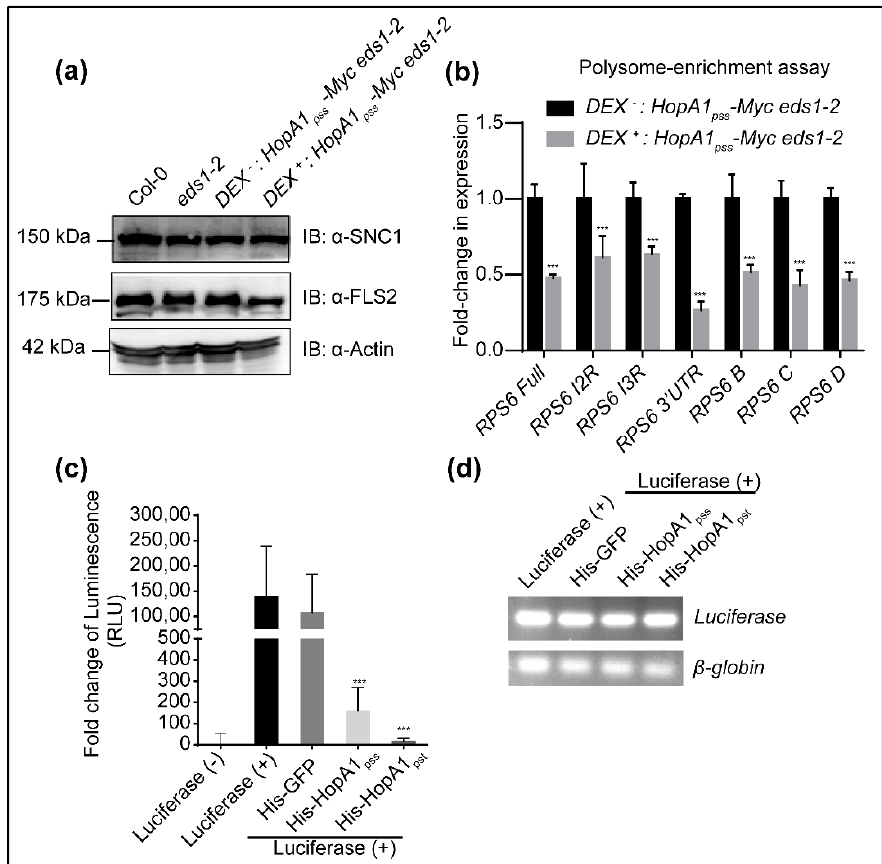
Figure 6. HopA1s display translational suppression activity. ( a ) Expression levels of SNC1 and FLS2 proteins in Col-0, eds1-2 , Dex − and Dex + HopA1 pss -expressing transgenic plants at 12 hpin. Immunoblots were performed with anti-SNC1, anti-FLS2 or with anti-actin as representative of loading control. ( b ) Transcript levels of RPS6 AS variants enriched on polysomes during ETI HopA1pss -like response. Values are mean ± SD of three replicates and shown as relative to Dex − levels. Statistical analysis is with pairwise comparison to Dex − or Luciferase (-) samples by Student’s t -test (*** p < 0.001). ( c ) HopA1 pss and HopA1 pst suppress reporter gene expression in in vitro transcription-translation coupled assay system. Luciferase ( LUC ) activity in the presence of equimolar amounts of His-HopA1 pss , His-HopA1 pst or His-GFP (negative control). ( d ) Semi-quantitative qRT-PCR of LUC and control β -globin expression in the above samples.